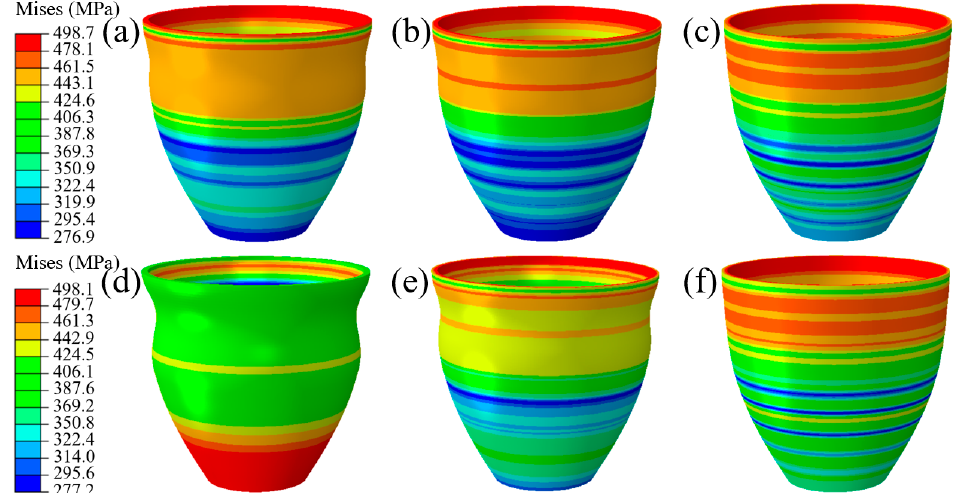
Figure 21. Mises stress distribution of formed parts in cases of 11.9 MPa and 13.9 MPa. ( a–c ) The evolution process of wrinkle morphology when P = 13.9 MPa ( d – f ) The evolution process of wrinkle morphology when P = 11.9 MPa.